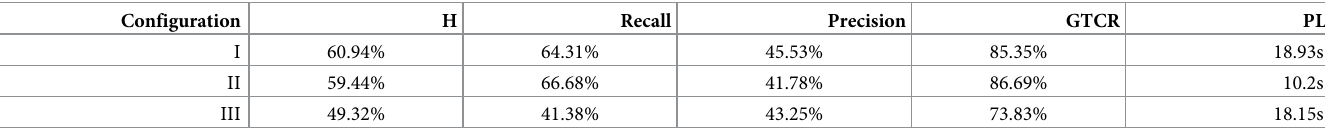
Table 1. Detailed results of the best configurations for Method A and Method D . Presented metrics ( H , Recall , etc.) are described in Section 5.1. The configurations parameters are: Configuration I ( Method A , best configuration) has f = 0.05, Delta = 0.06, Configuration II ( Method A , recommended configuration) has f = 0.1, Delta = 0.12, Configuration III ( Method D ) has f = 0.05, Delta =